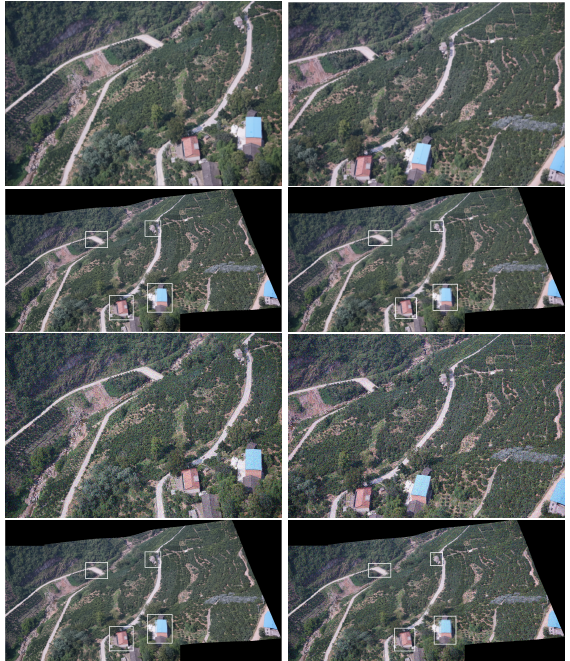
Figure 9. The first line is the blurred source image. The second line is the mosaic result of the unblurred source image and the mosaic result of the blurred source image. The third line is the noisy source image. The fourth line is the mosaic result of the source image without noise and the mosaic result of the source image with noise. White boxes highlight the ghostly parts.